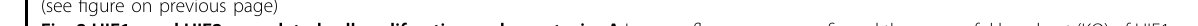
Fig. 2 HIF1 α and HIF2 α regulated cell proliferation and apoptosis. A Immuno fl uorescence con fi rmed the successful knockout (KO) of HIF1 α and HIF2 α in HIF1 α -KO, HIF2 α -KO and HIF1 α /HIF2 α -KO cells. B We cultured empty vector cells, HIF1 α -KO cells, HIF2 α -KO cells, HIF1 α /HIF2 α -KO cells in 1% O 2 for 24 h, KEGG pathway analysis revealed fi ve common and signi fi cant signalling pathways, including the HIF signalling pathway, EGFR pathway, PI3K – AKT signalling pathway and signalling pathways regulating the pluripotency of stem cells and cell cycle using KEGG. C There were no differences in HIF1 α and HIF2 α between the control and empty vector groups after culturing both cells in 1% O 2 for 72 h. However, the expression of HIF1 α increased signi fi cantly after knocking out HIF2 α ; and HIF2 α expression increased signi fi cantly after knocking out HIF1 α . D After individually knocking out HIF1 α or HIF2 α , there were no differences in cell proliferation between the HIF1 α -KO or HIF2 α -KO cells and the empty vector cells. However, after simultaneously knocking out HIF1 α and HIF2 α , the cell proliferation rate increased signi fi cantly compared with the cell proliferation rates in other groups, including empty vector cells, HIF1 α -KO cells or HIF2 α -KO cells. Then, TMZ (400 μ M) was added to the culture medium for another 72 h, and the cell proliferation became slower in HIF1 α -KO or HIF2 α -KO cells than in the empty vector cells; however, the slowest proliferation rate was found in the HIF1 α /HIF2 α -KO cells. E Cell apoptosis detection showed no difference in early apoptosis, but late and total apoptosis rates increased in HIF1 α -KO or HIF2 α -KO cells. However, after simultaneously knocking out HIF1 α and HIF2 α , there was a signi fi cant increase in early, late and total apoptosis rates compared with those in other groups. P values were determined by one-way